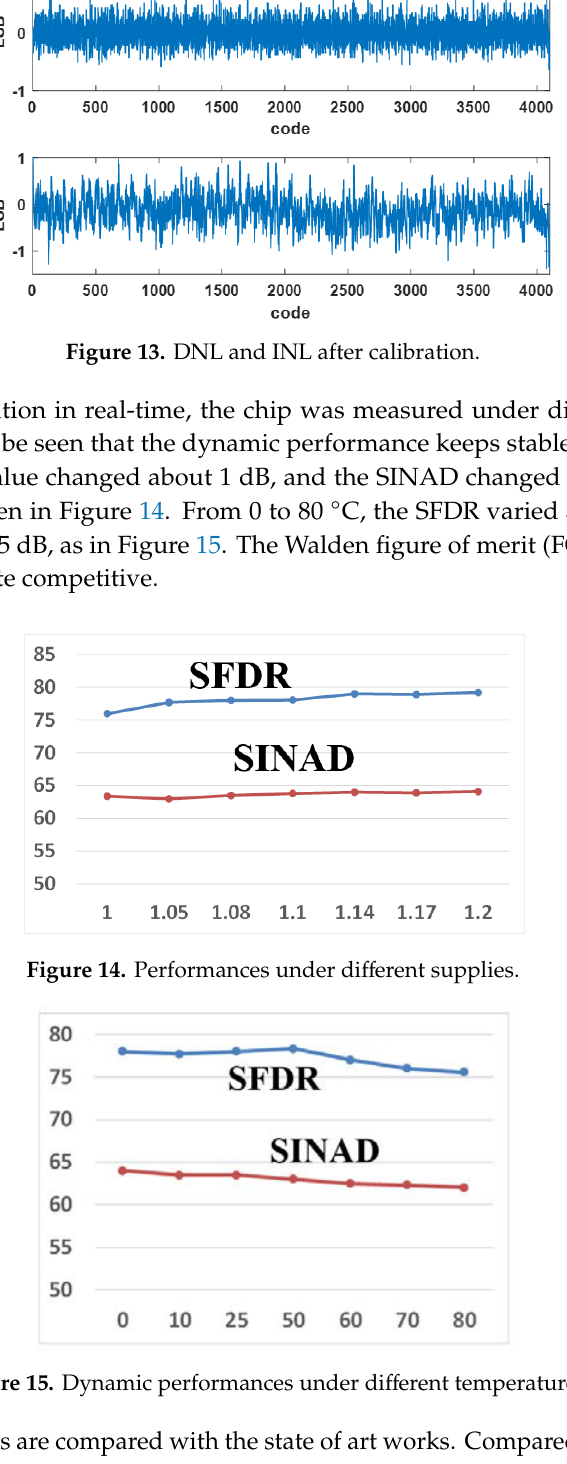
Table 1. Performance of the proposed ADC and comparison with previous studies.